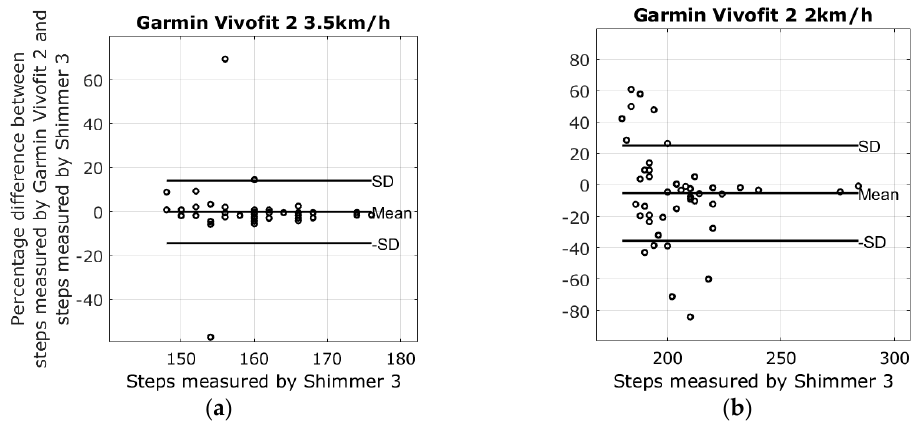
Figure 3. Results from the walking tests with plots showing the difference between the steps measured by the Garmin Vivofit 2 and the Shimmer 3. ( a ) The percentage error of the 3.5 km/h walking test is − 0.2 ± 14.2; ( b ) The percentage error of the 2 km/h walking test − 5.3 ± 30.4.